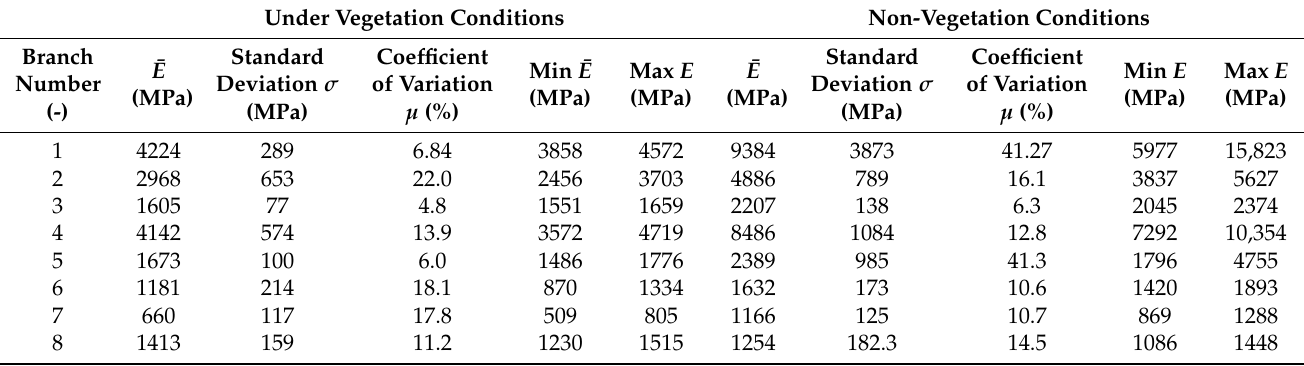
Table 6. Summary of the calculated modulus of elasticity for individual branches of shrub No. 1 under the vegetation and non-vegetation